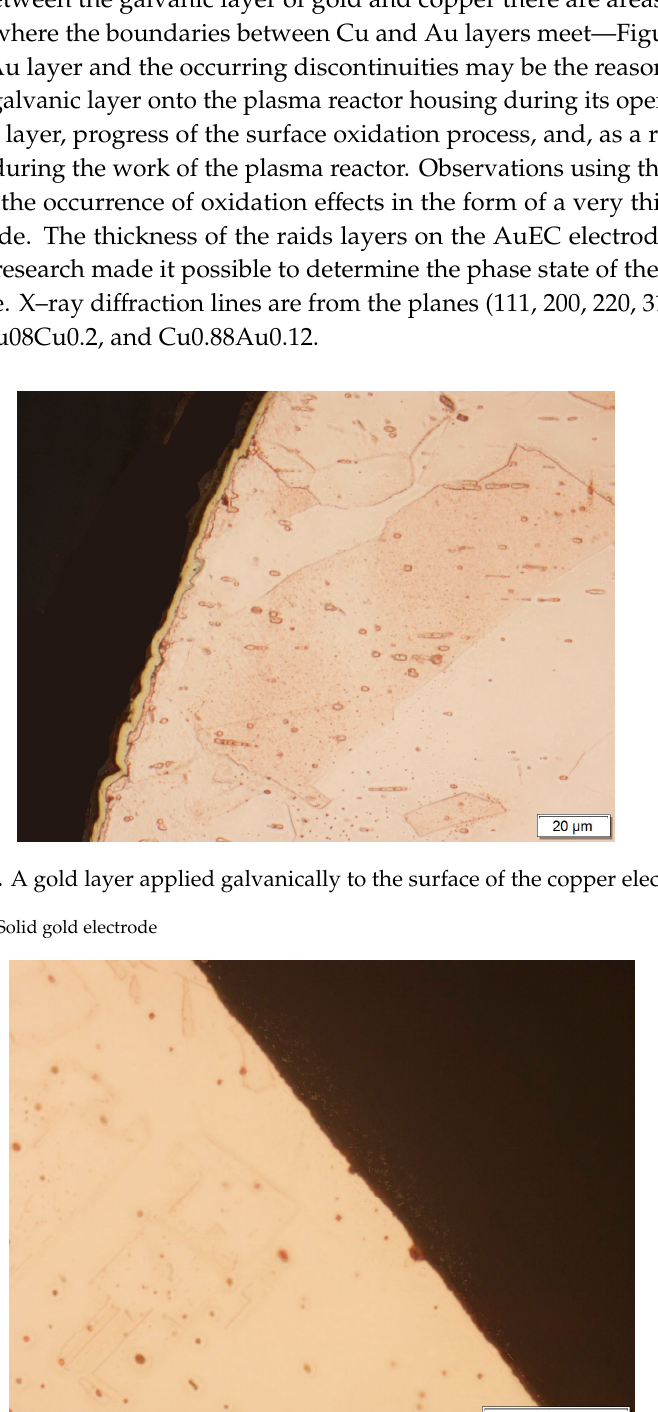
Figure 7. A diffractogram of the surface of a copper electrode galvanized and coated by gold.